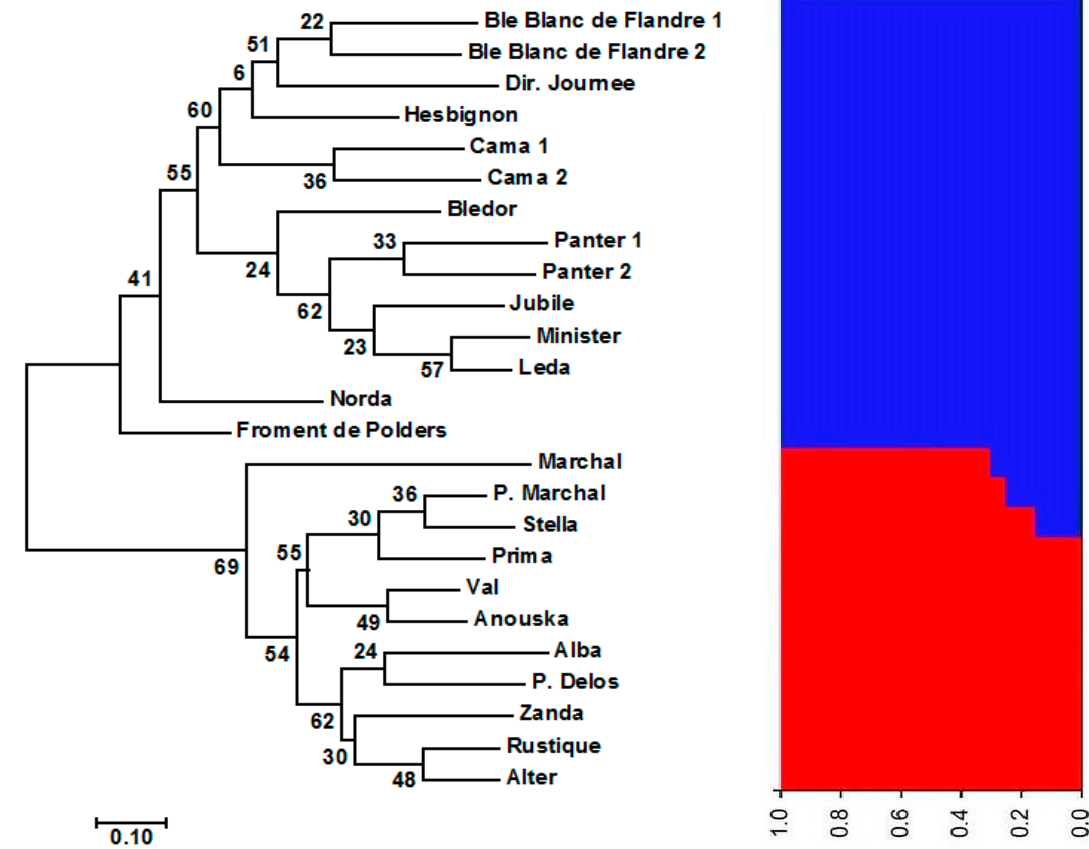
Figure 3. Neighbor-joining tree of the 25 Belgian wheat genotypes and their population structure (at K = 2) based on 1052 DArT markers. The numbers at the nodes of the phylogenetic tree represent the bootstrap values showing the probability of branching at 1000 replications. The red and blue colors represent two different populations.